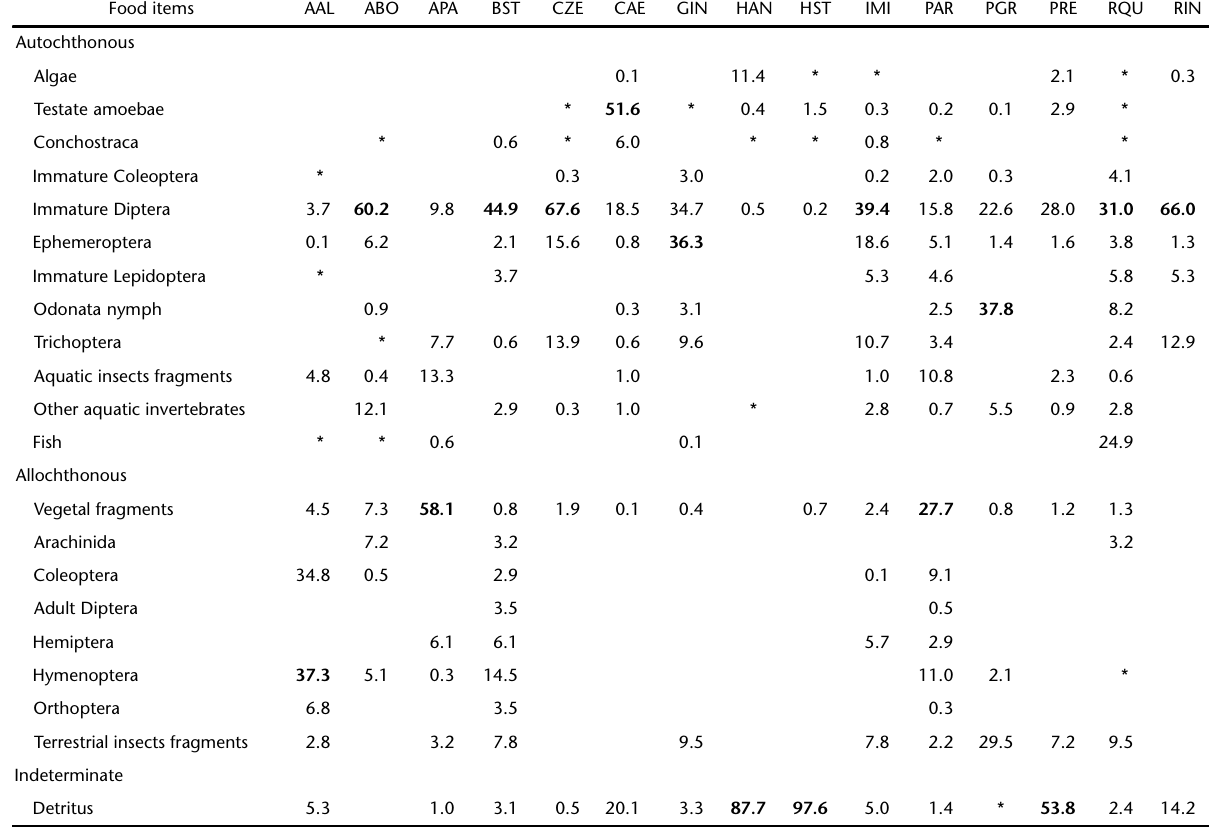
Table III. Food items consumed by the studied species and the origin of the food items. Values are based on data indicating the volume percentage of the item consumed. Asterisk indicates values less than 0.1%. The most significant values for each species are shown in bold. Food items